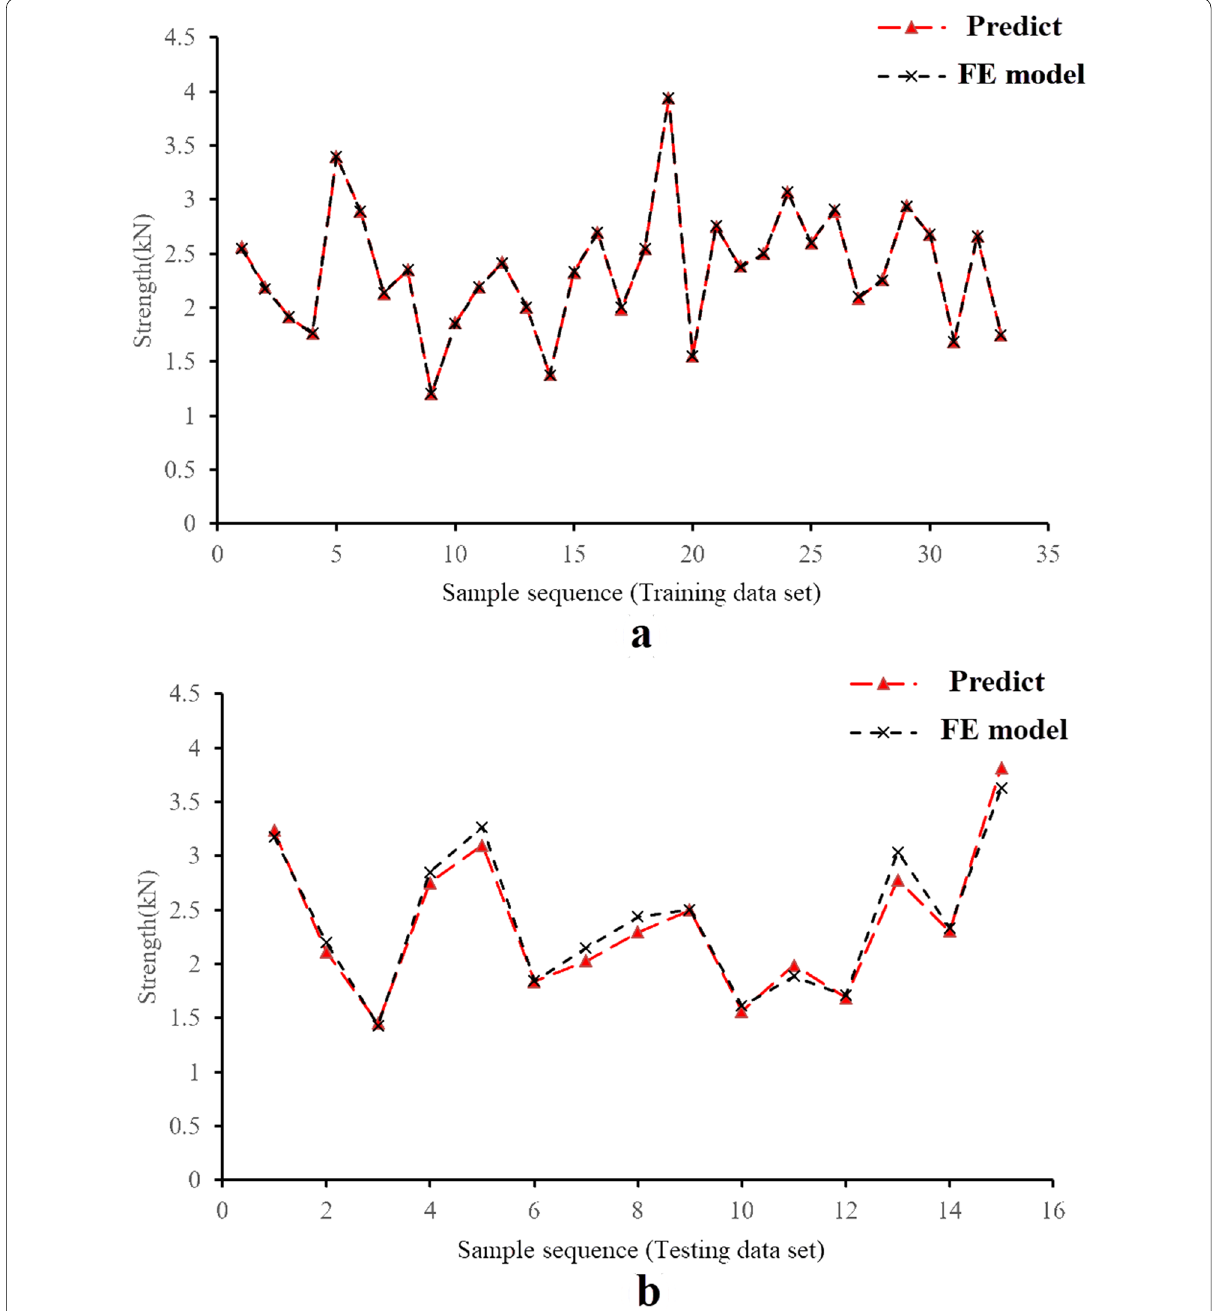
joint was tested as a reference value for the predic- tion value of XGBoost regression model. As shown in Table 6, the averaged cross-tension strength of three joints was measured as 2.52 kN, and the cross-tension strength obtained from FE model simulation is 2.69 kN, while the predicted strength value of SPR-C joint